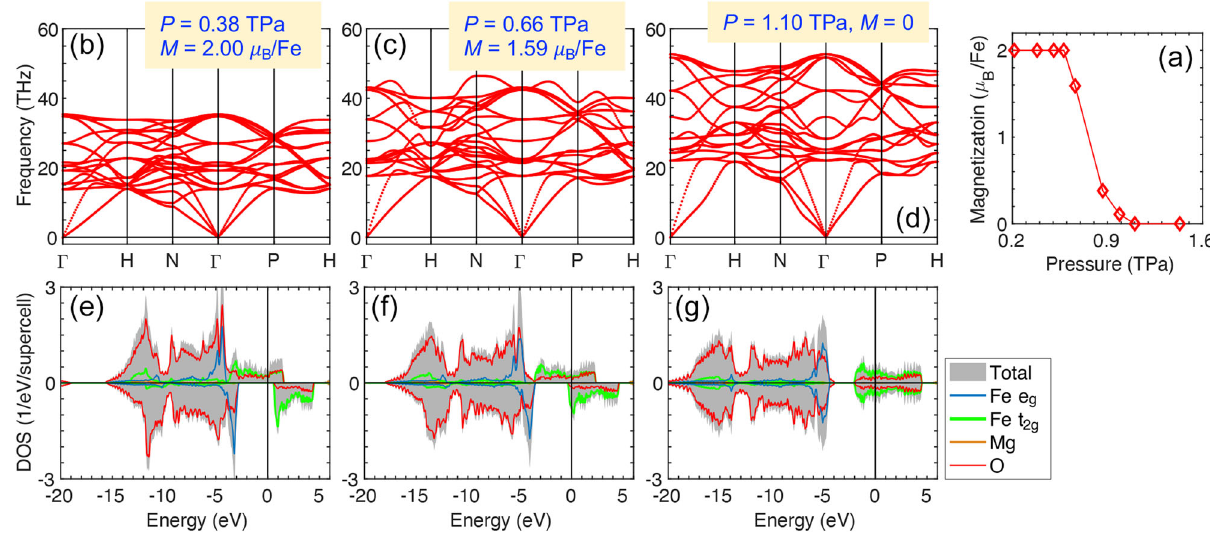
Fig. 5 Stability, electronic structure, and magnetic collapse of cubic B2 intermediate-spin (IS) (Mg 0.75 Fe 0.25 )O. a Total magnetization ( M ); b – d phonon dispersion; e – g total and projected density of states (DOS), with the Fermi energy set as the reference (0 eV). Panel ( a ) indicates that the IS state retains M > 0 at P < 1.1 TPa. At P ≥ 1.1 TPa, only the nonmagnetic low-spin (LS) state ( M = 0) can be obtained. Panels ( d ) and ( g ) thus also indicate the LS results.